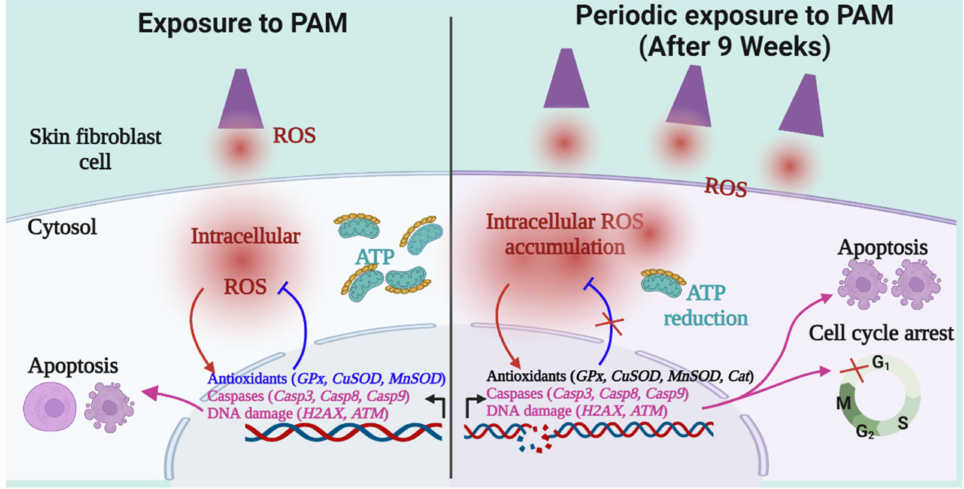
Figure 6. An illustration depicting the impact of periodic redox stress in skin fibroblasts. This figure is prepared using licensed BioRender online